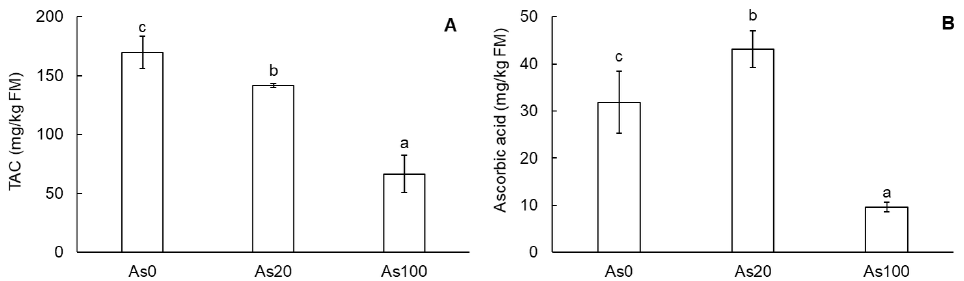
Figure 3. Total anthocyanin content ( A ) and ascorbic acid ( B ) in tubers of cherry radish. Values represent the mean ± SD. Data with the same letter are not significantly different. Different letters indicate significant differences ( p < 0.05) among treatments according to ANOVA with Tukey’s post- hoc test. Abbreviations: As0—0 mg As/kg soil (control); As20—20 mg As/kg soil; As100—100 mg As/kg soil; TAC—total anthocyanin content (mg/kg FM); FM—fresh matter.